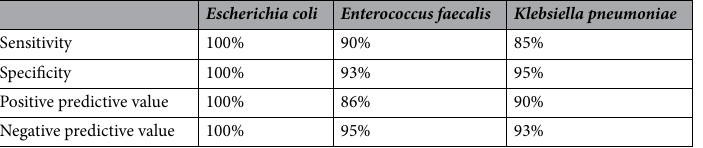
Table 5. Classification statistics for PC-LDA-based identification of bacterial species in infected samples.